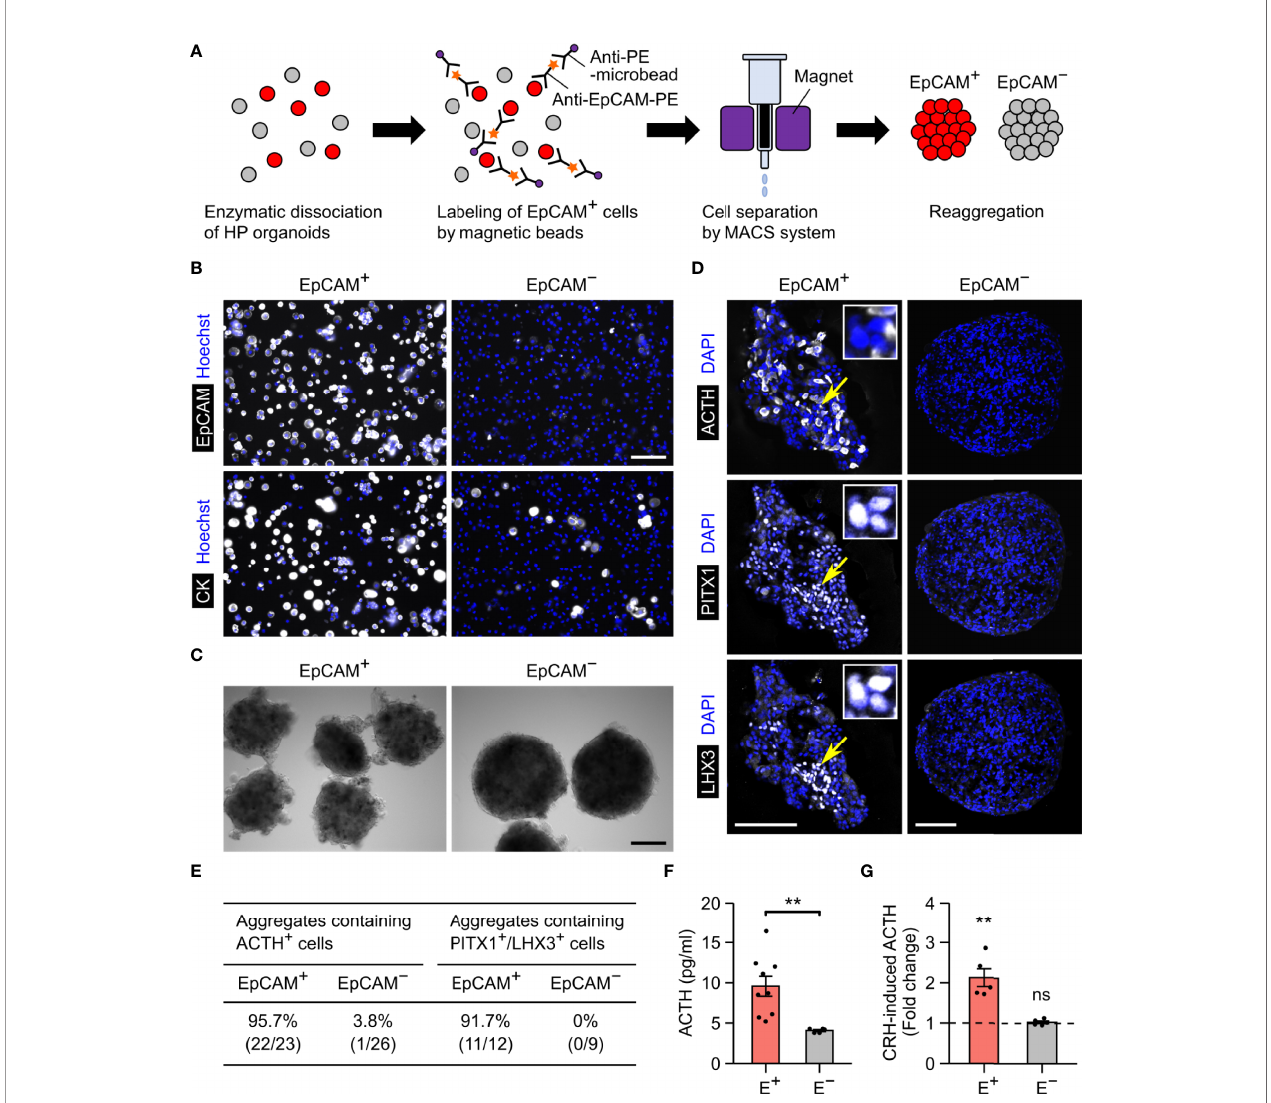
FIGURE 3 | EpCAM-based sorting of anterior pituitary cells from HP organoids. (A) A schematic illustration of the cell sorting protocol. (B) Double immunostaining of MACS-separated cells for EpCAM and cytokeratin. Nuclei were stained with Hoechst. The fl uorescence signals for EpCAM represent the PE labels added during the sorting process. (C) Representative images of EpCAM + and EpCAM − cell aggregates. (D) Triple immunostaining of an EpCAM + or EpCAM − aggregate for ACTH, PITX1, and LHX3. Nuclei were stained with DAPI. In the left panels, the insets show high-magni fi cation images of three PITX1 + /LHX3 + cells indicated by arrows. (E) Quanti fi cation of EpCAM + and EpCAM − aggregates containing ACTH + or PITX1 + /LHX3 + cells. Aggregates were obtained by at least two independent MACS experiments (see Materials and Methods). (F) The spontaneous secretion of ACTH from EpCAM + (E + ) and EpCAM − (E − ) aggregates. n = 9 (EpCAM + ) or 5 (EpCAM − ) experiments. ** p = 0.00219 by Welch ’ s t test. (G) The fold change of ACTH secretion after CRH stimulation ( n = 5 experiments). The mean value for EpCAM + aggregates was signi fi cantly larger than 1 (** p = 0.00714 by one-sample t test), but that for EpCAM − aggregates was not (ns: not signi fi cant, p = 0.3983 by one- sample t test). Scale bars: 100 µm (B, D) , 200 µm (C)